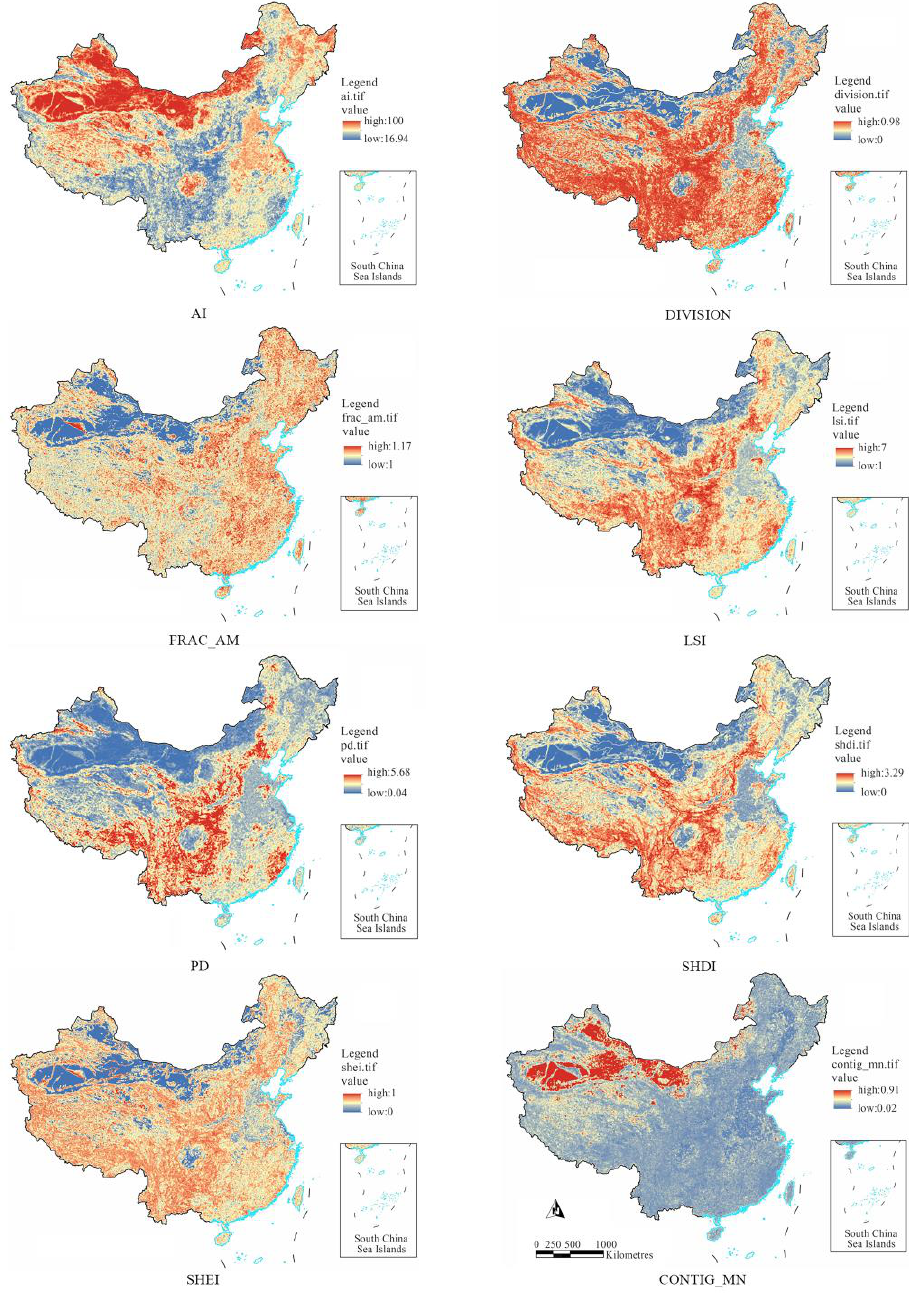
Figure 4. Eight landscape structure factors (LSFs) corresponding to a scale of 14 km.